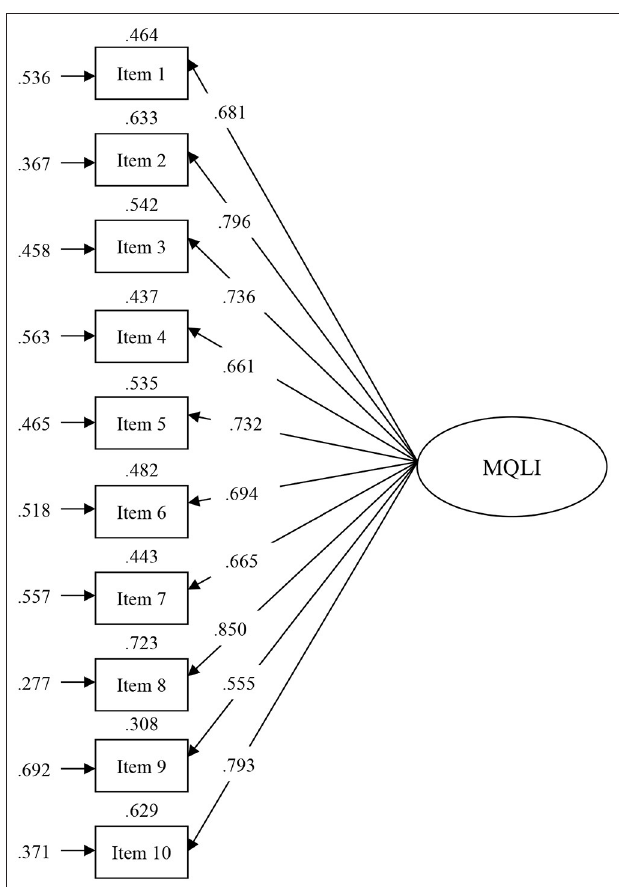
FIGURE 1 | Model obtained in the present study for the MQLI. Values at the top of each rectangle are R 2 ; values at the left of each rectangle are errors; parameter estimates and residual variances are